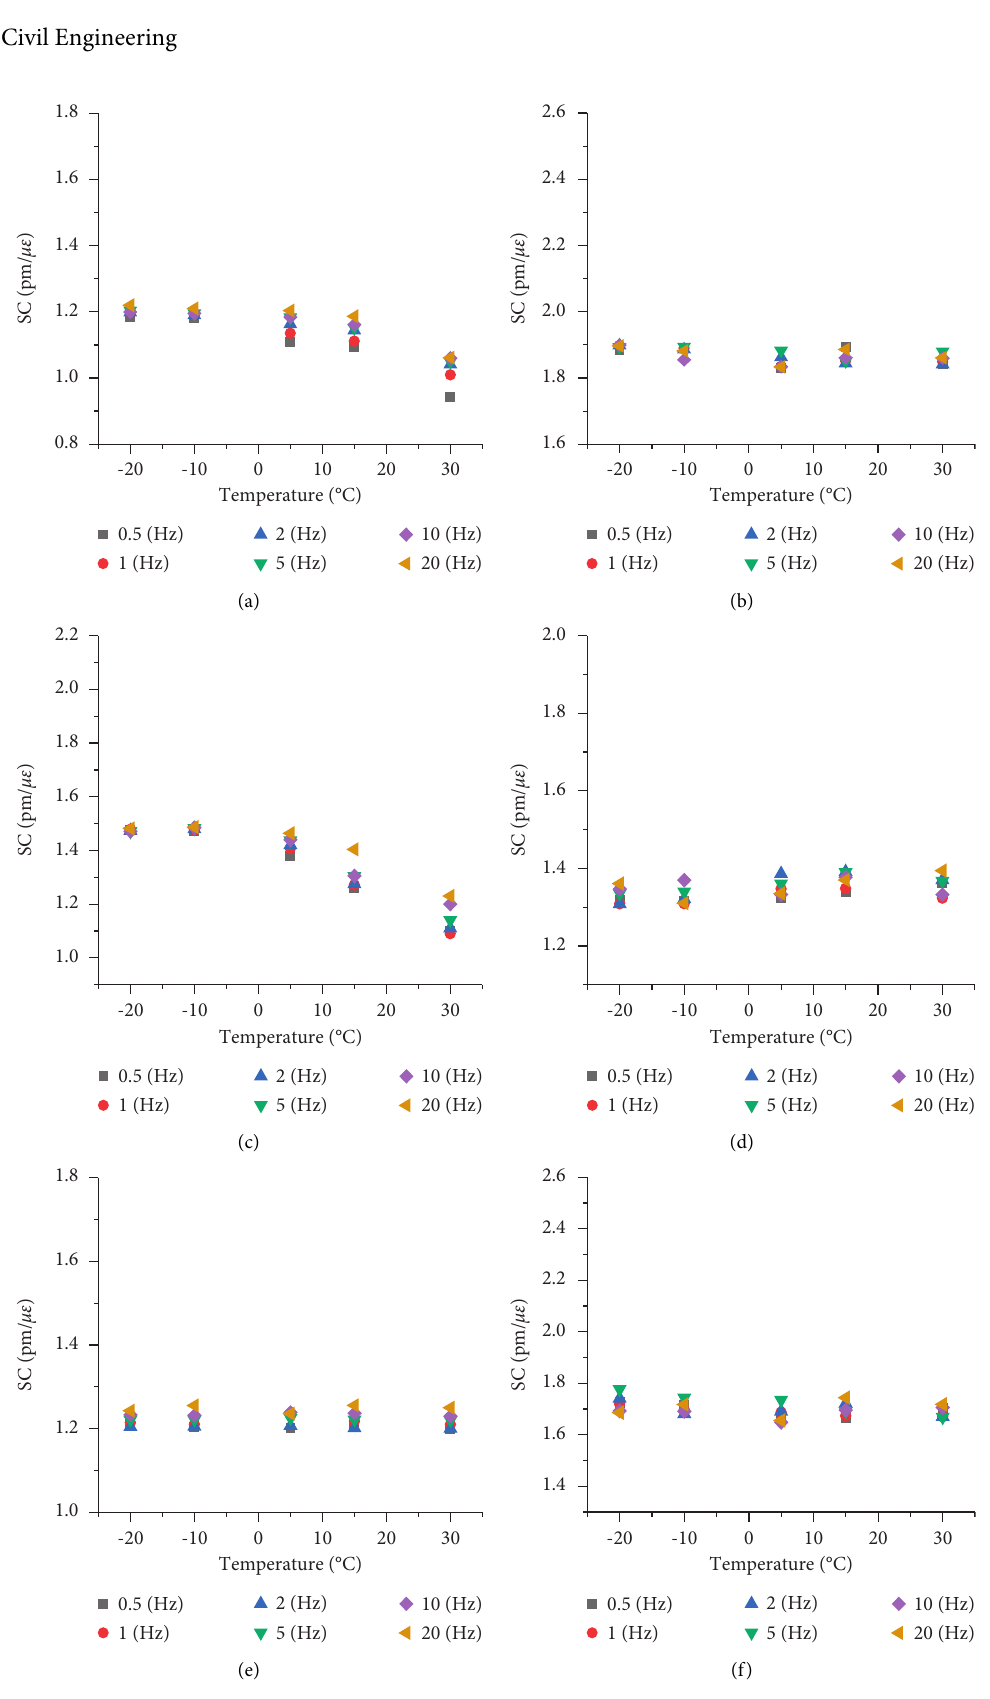
Figure 7: Calculated SC results. (a) FBGS-1+AC-25; (b) FBGS-1 +CSCS; (c) FBGS-2+AC-25; (d) FBGS-2 +CSCS; (e) FBGS-3 +AC-25; (f) FBGS-3